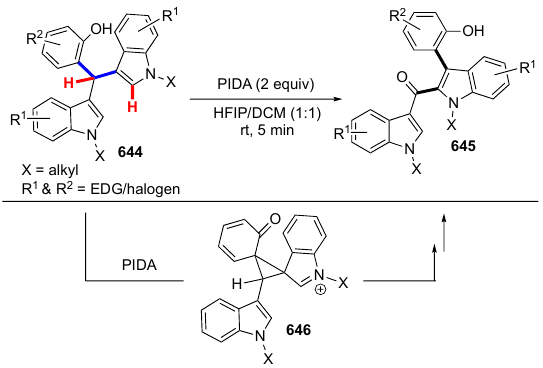
Scheme 83. PIDA-mediated rearrangement of unstrained diindolylmethanes.